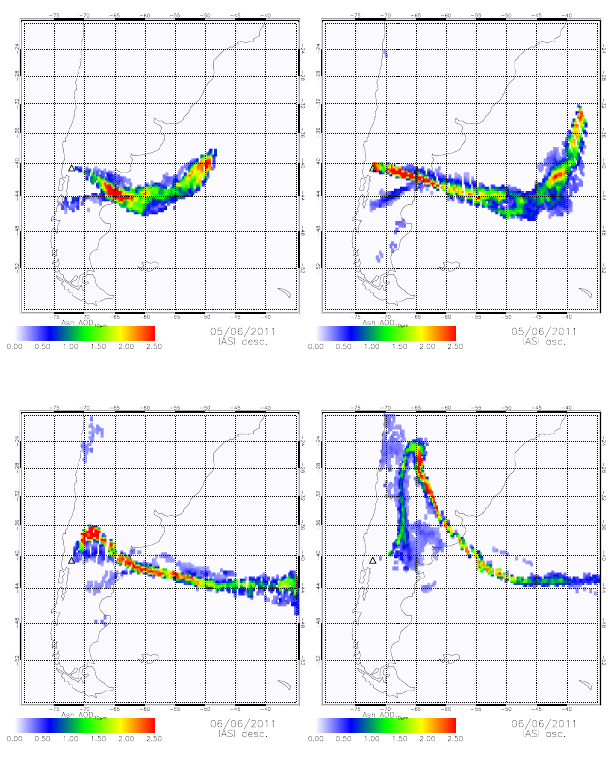
Fig. 2. Ash Optical Depth at 10µm of the PCCE plume for 5 through 6 June. Descending (desc.) orbits represent morning observations, ascending (asc.) orbits are from local evening. The black triangle indicates the position of the volcano.